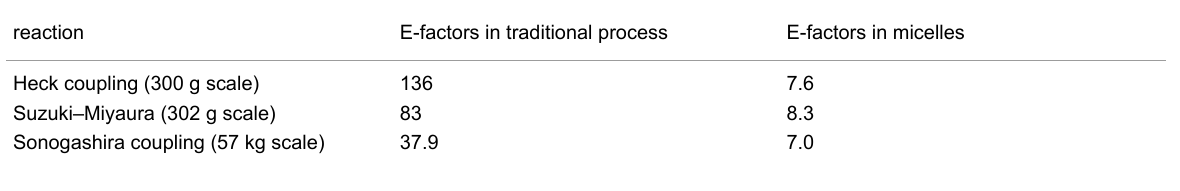
Table 1: Representative comparison of E-factors (including the aqueous work-up), of a pharmaceutically relevant synthesis, carried out via a tradi- tional and a micellar process [45].